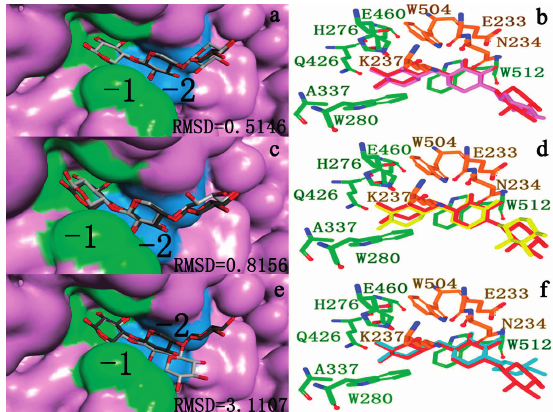
Figure 7. ( a ) the compartment between the docked ligand (dark gray) and the reference for the crystal structure (light gray) located in the active cleft. Calculated by CDOCKER [46]; ( b ) the subsite − 1 and − 2 residues around the docked ligand (purple) and the reference for the crystal structure (red); ( c ) the compartment between the docked ligand (dark gray) and the reference for the crystal structure (light gray) located in the active cleft. Calculated by Autodock vina [47]; ( d ) the subsite − 1 and − 2 residues around the docked ligand (yellow) and the reference for the crystal structure (red); ( e ) the compartment between the docked ligand (dark gray) and the reference for the crystal structure (light gray) located in the active cleft. Calculated by Autodock 4.2 [48]; ( f ) the subsite − 2 and − 1 residues around the docked ligand (dark blue) and the reference for the crystal structure (red).